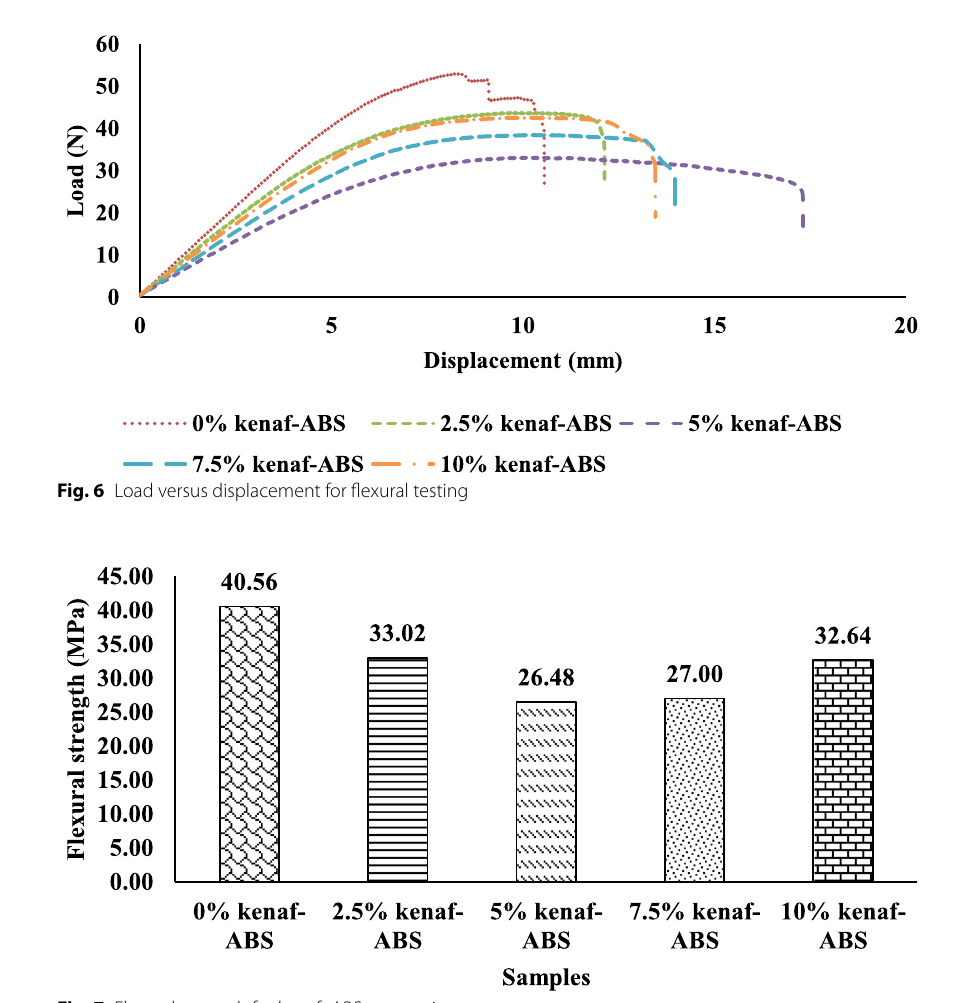
Fig. 7 Flexural strength for kenaf–ABS